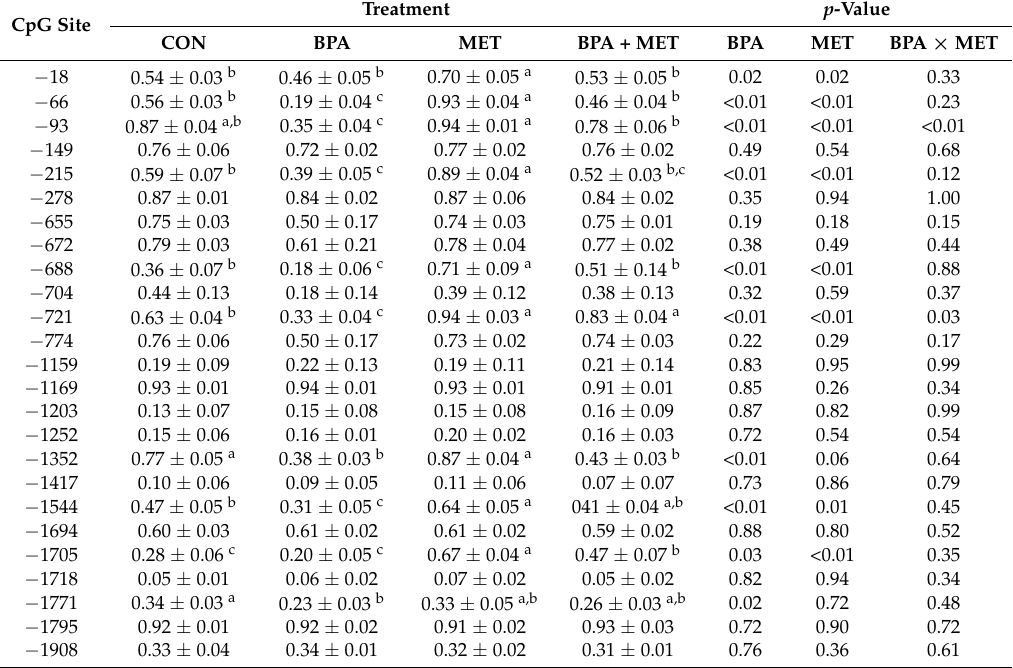
Table 8. Effect of maternal methyl donor or bisphenol A supplementation during gestation on the jejunum Pept1 gene DNA methylation level in newborn